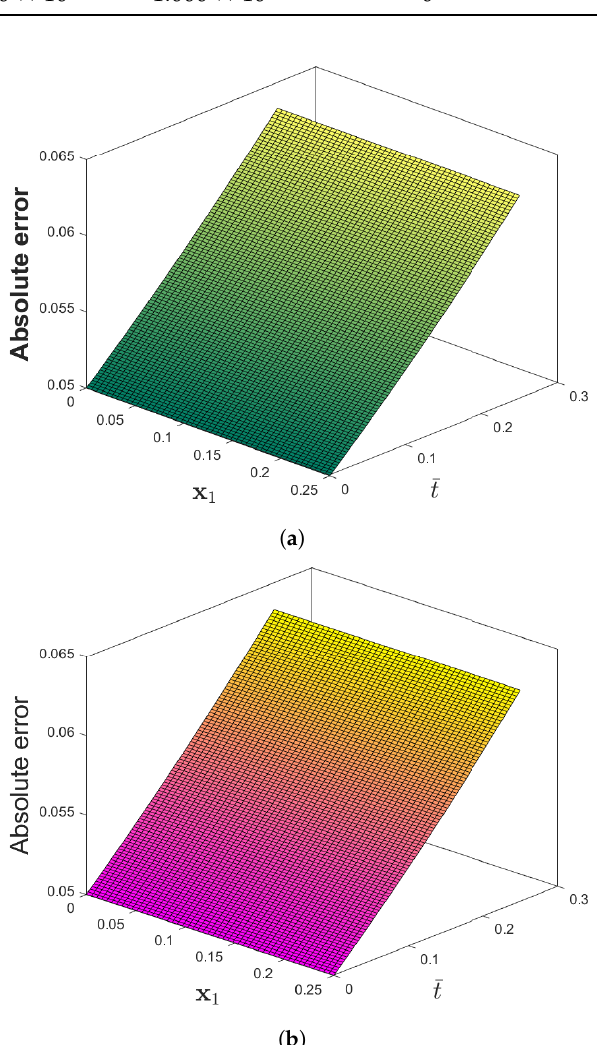
Figure 2. ( a ) Absolute error plots of f ( x 1 , ¯ t ) for Problem 1 for ( a ) CFD and ( b ) ABC when the parameters are η = 0.05, θ = 1, β = 1, and ϕ =